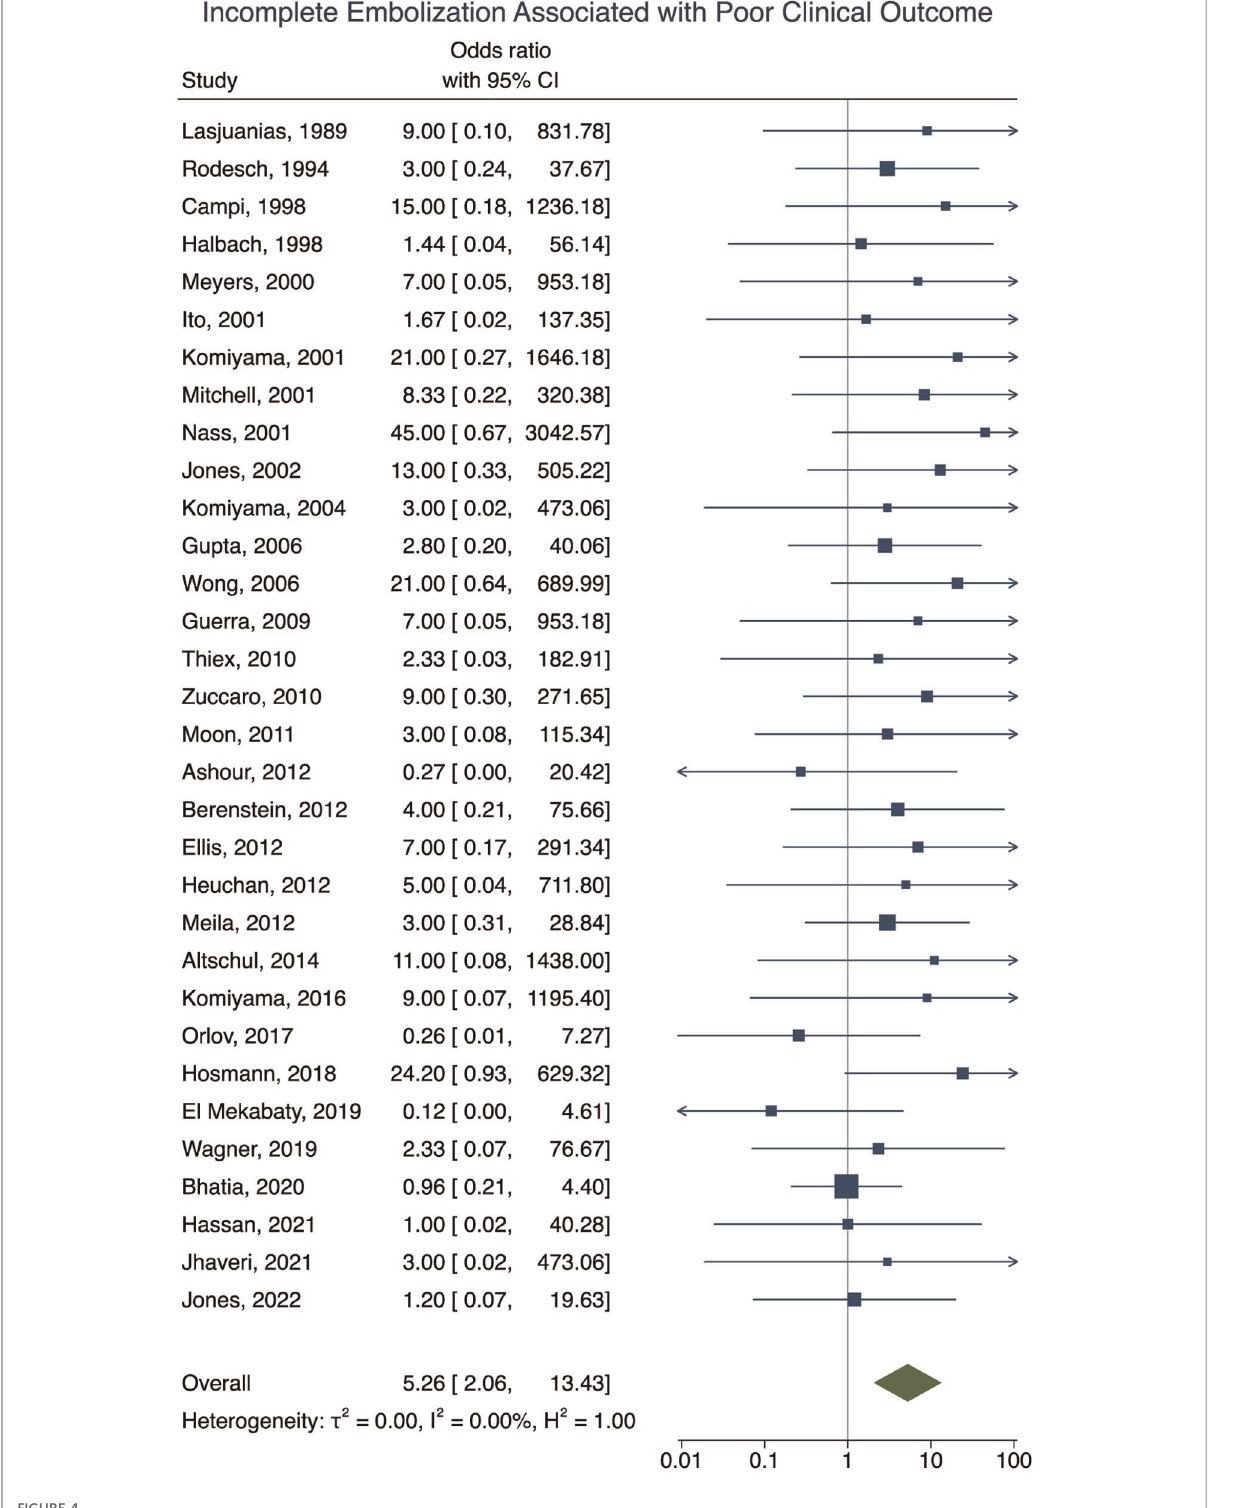
FIGURE 4 Forest plot showing the association of incomplete embolization with poor clinical outcome after VOGM